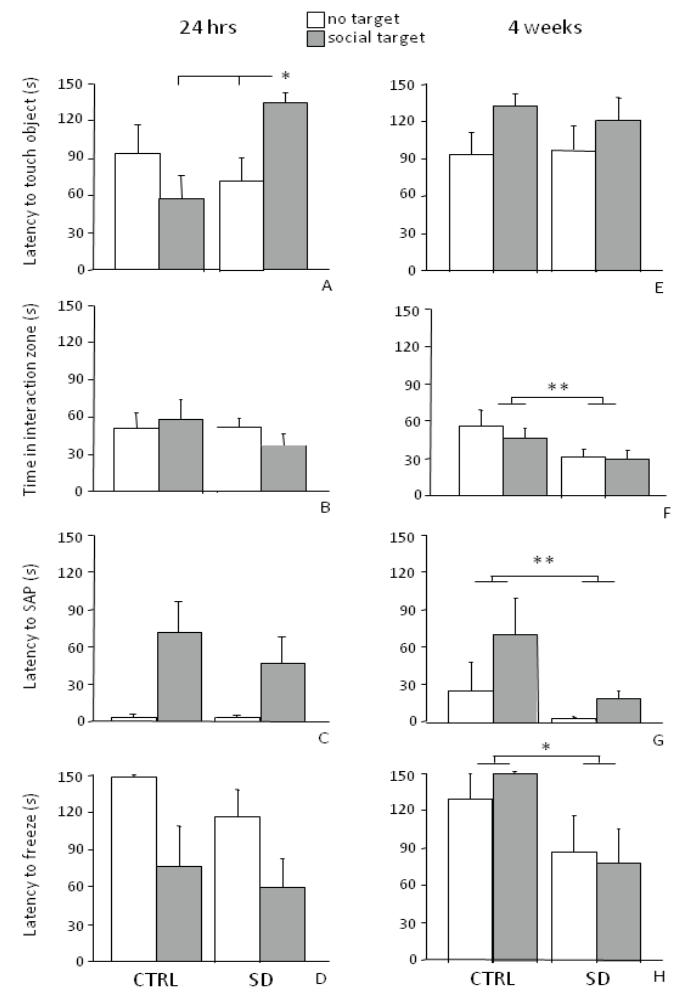
Figure 4. Social Avoidance Test (SAT). The presence of a social stimulus increased the latency of SD mice to touch the wire mesh cage ( touching object ) 24 h ( A ) but not 4 weeks after the end of the stress procedure ( E ). Overall, independently from the presence of the social stimulus, in the long-term situation (4 weeks), SD subjects spent less time in the interaction zone than CTRLs ( F ), showed both a shorter latency to perform SAP ( G ) and to freeze ( H ). No difference was found between SD and CTRL mice in the short-term condition ( B , C and D , respectively). Data are presented as mean + S.E.M. n = 7 (SD) and 6 (CTRL). Subjects were tested only once either at 24 h or 4 weeks from the end of SD. * p < 0.05. ** p < 0.01 (main effect of the social condition).